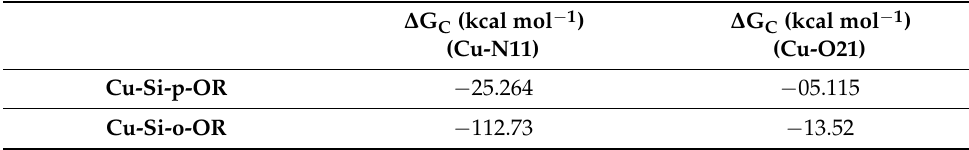
Table 8. Gibbs free energies of complexation ( ∆ G C ) for the studied